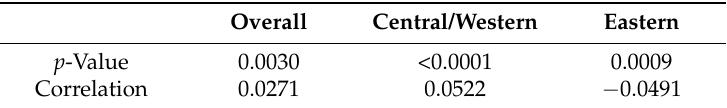
Table 3. Weighted sample size correlation between longest duration of good air quality in autumn/winter and health scores for each